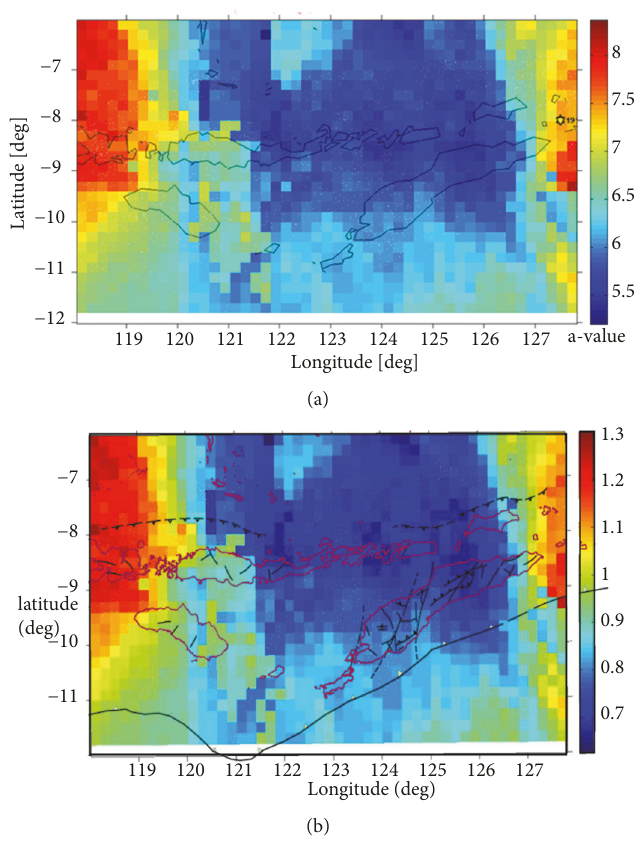
Figure 7: Spatial variation map of (a) a-values and (b) b-values for all earthquakes in